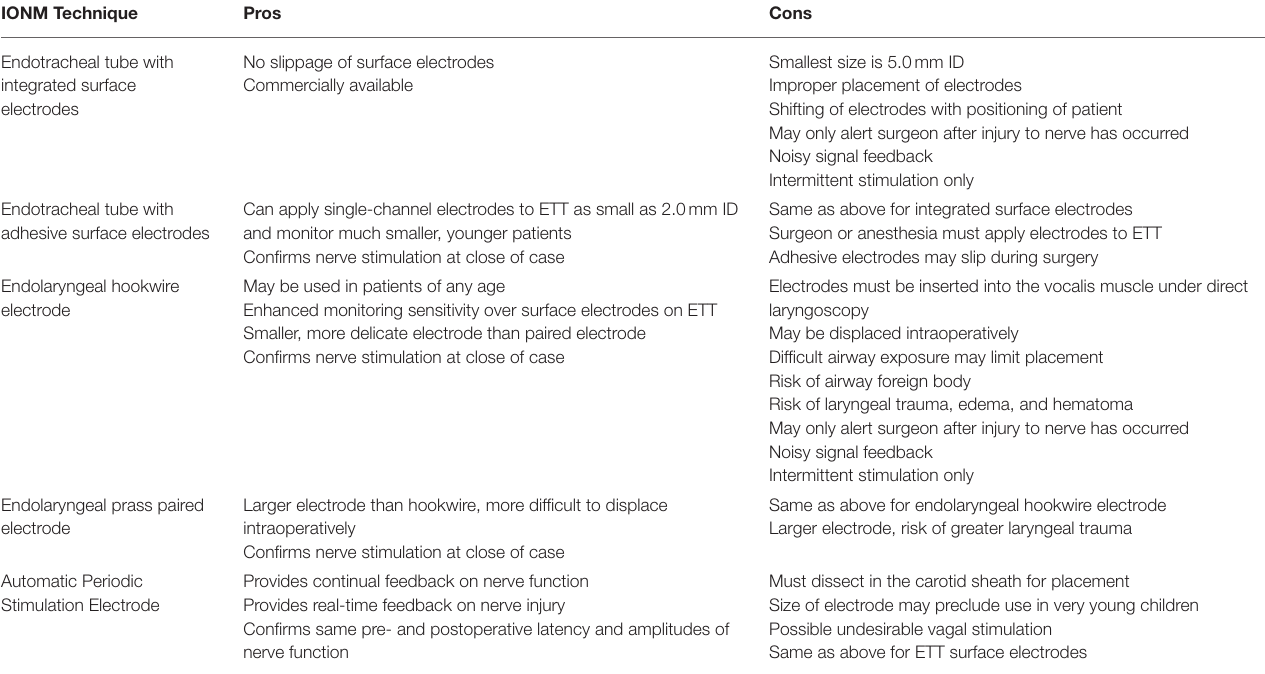
TABLE 1 | Pros and cons of IONM